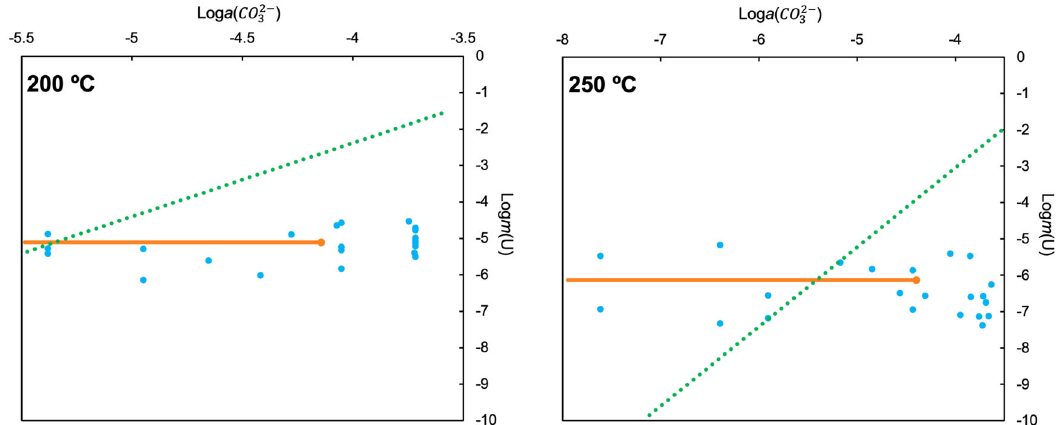
Fig. 3 Measured and calculated solubilities of UO 2 (OH) 2 as functions of calculated carbonate activity at 200 and 250 °C. Measured solubilities are shown as dark blue points and calculated solubilities for the same system are shown in light blue. A gradient of 3 for the calculated solubilities would suggest a predominance of the UO 2 (CO 3 ) 3 4 − complex, which, however, is not the case as revealed by the experimental results. The dark gray line delineates a range of carbonate activities for groundwater and uranium-bearing hydrothermal systems. Note that data spreads spanning an order of magnitude are typical for autoclave solubility experiments.